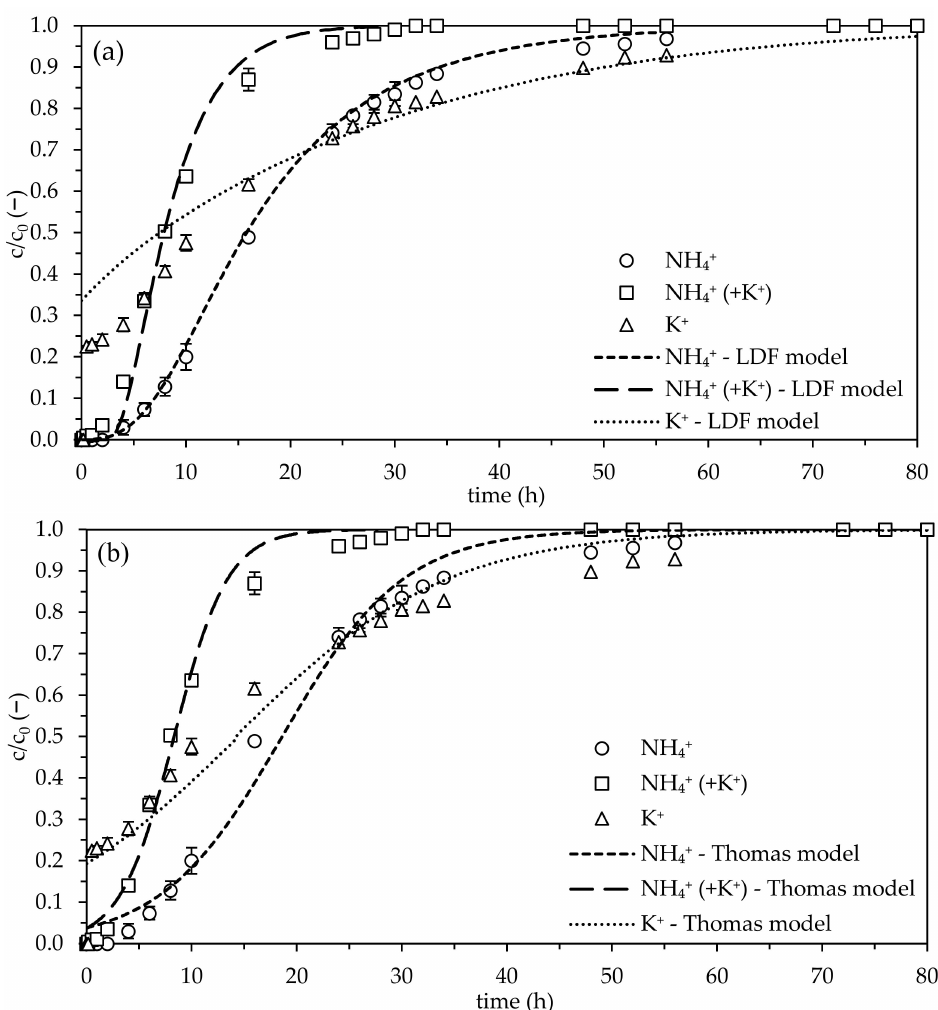
Figure 1. Experimental NH 4+ and K + breakthrough curves and their modeling using the LDF model ( a ) and the Thomas model ( b ) (matrix: ultrapure water; c 0 (NH 4+ ) = 0.7 mmol/L, c 0 (NH 4+ , K + ) = 0.7 mmol/L, c 0 (K + ) = 0.7 mmol/L; v F = 1.74 m/h; EBCT: 2.16 min; pH 0 : 5.9; T = 22 ◦ C; n =